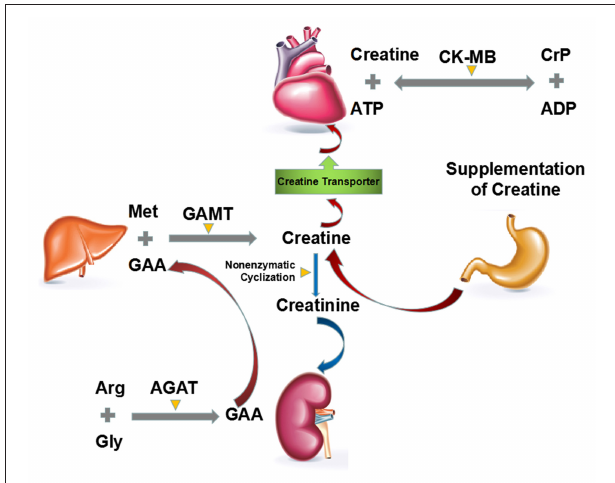
FIGURE 3 | Major routes of biosynthesis, degradation and turnover of endogenous CrP. The biosynthesis of CrP begins by formation of creatine from three essential amino acids: arginine, glycine, and methionine. The main route of creatine synthesis involves formation of GAA in kidney, and methylation in liver. These reactions are, respectively, catalyzed by AGAT and GAMT. Then creatine is transported to heart by a specific Na + - and Cl − -dependent plasma membrane transporter. The degradation of creatine and CrP is an irreversible, non-enzymatic cyclization to creatinine, which should be supplemented by diet or de novo biosynthesis. ADP, adenosine diphosphate; AGAT, L-arginine:glycine amidinotransferase; ATP, adenosine triphosphate; CK, creatine kinase; CrP, creatine phosphate; GAA, guanidinoacetic acid; GAMT, S-adenosyl-L-methionine:N-guanidinoacetate